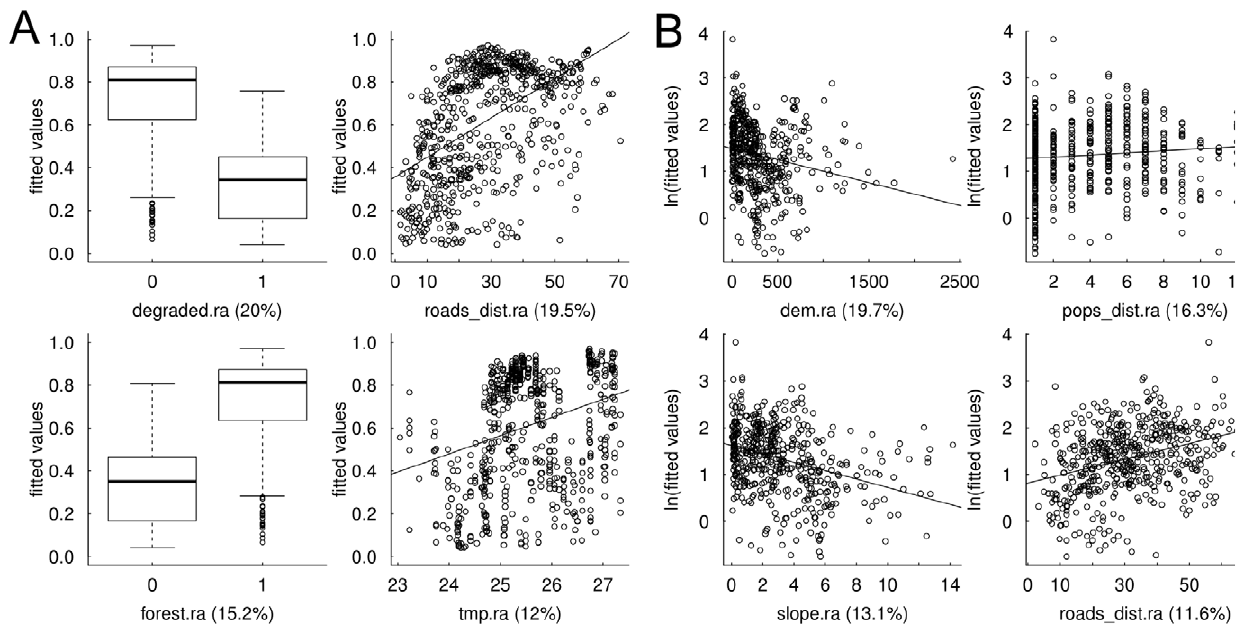
Figure 2. Relationships between nest presence and abundance and their four most influential predictors. Figures showing the relationship between (a) orangutan nest presence and (b) orangutan nest abundance and their four most influential predictors in the final saturated hurdle Species Distribution Model. Solid lines are the robust linear regression fit using Huber weights and fitted by Iterated Re-weighted Least Squares and indicate the direction of the relationship between the response and predictor variables. The relative importance of each predictor is given in parentheses on the x -axis. Note: abundance fitted values are ln transformed and zero values are not presented.